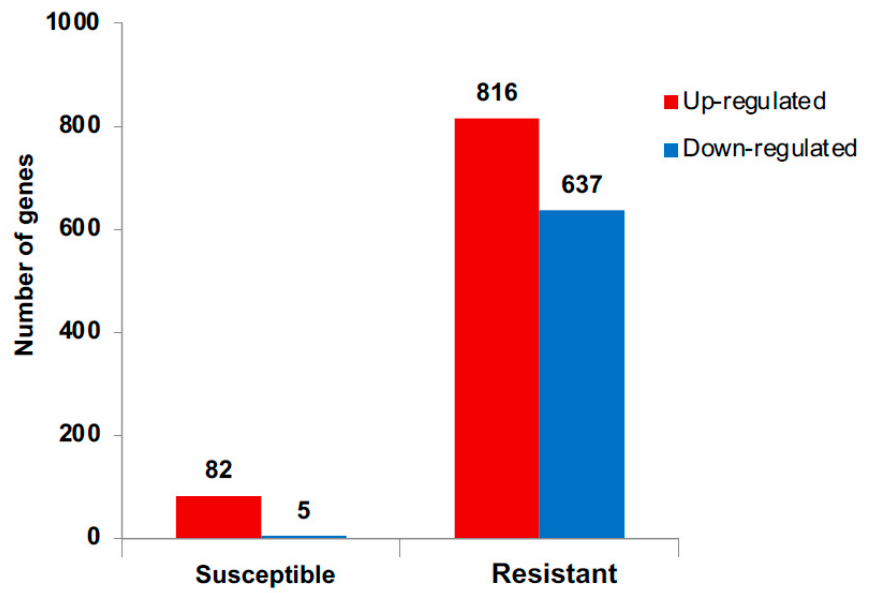
Figure 1. Numbers of differentially expressed genes (DEGs) in the susceptible and resistant wheat in response to wheat curl mite herbivory. DEGs were defined as having a fold change of ≥ 1.9 or ≤− 1.9 with a false discovery rate (FDR)-adjusted p -value of <0.05.